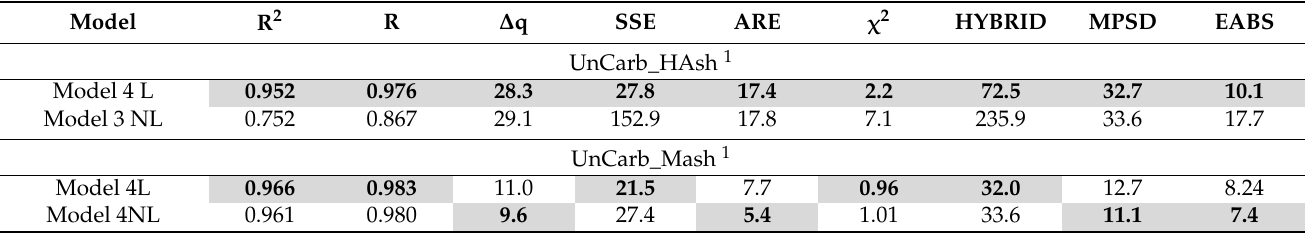
Figure 5. Summary of model and experimental curves for linear and non-linear regression for the following mixtures: ( a – e ) SO 2 + Ar, ( f , g ) SO 2 + O 2 + H 2 O (g) + Ar. Table 6. Error analysis for kinetic models solved by linear and non-linear regression methods.